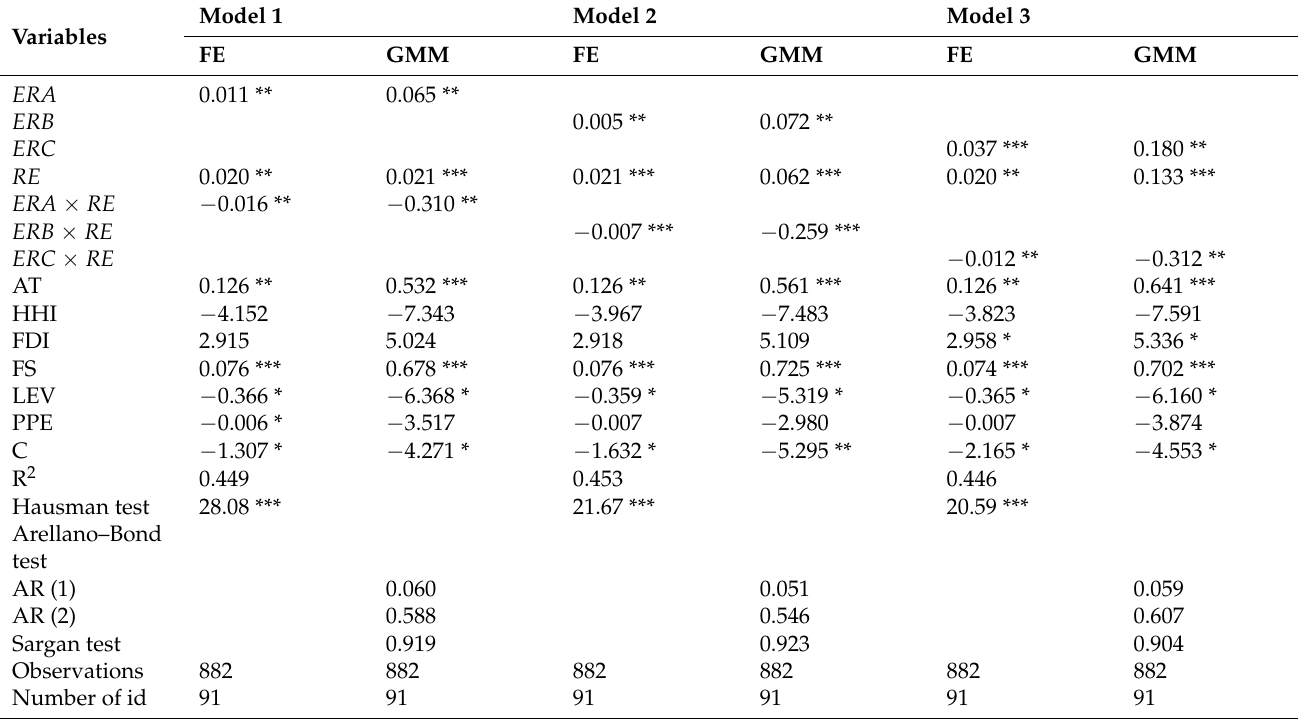
Table 6. Measurement results of the relationship between ER and SG with moderating effect of RE